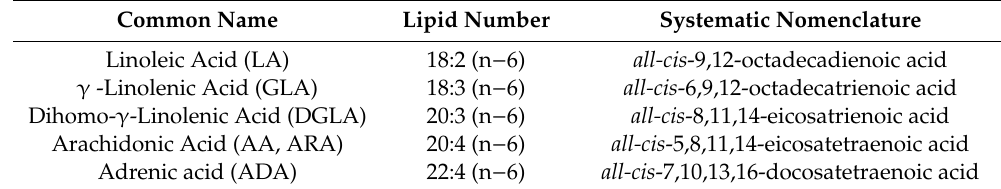
Table 2. Main n-6